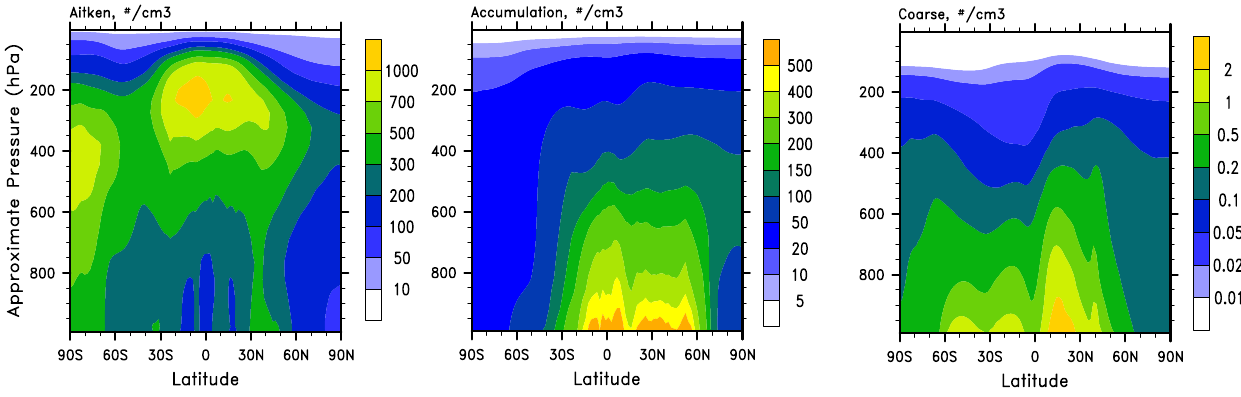
Fig. 4. Zonal mean aerosol number concentrations (numbercm − 3 ) for the Aikten mode, accumulation mode, and coarse mode predicted by the model.